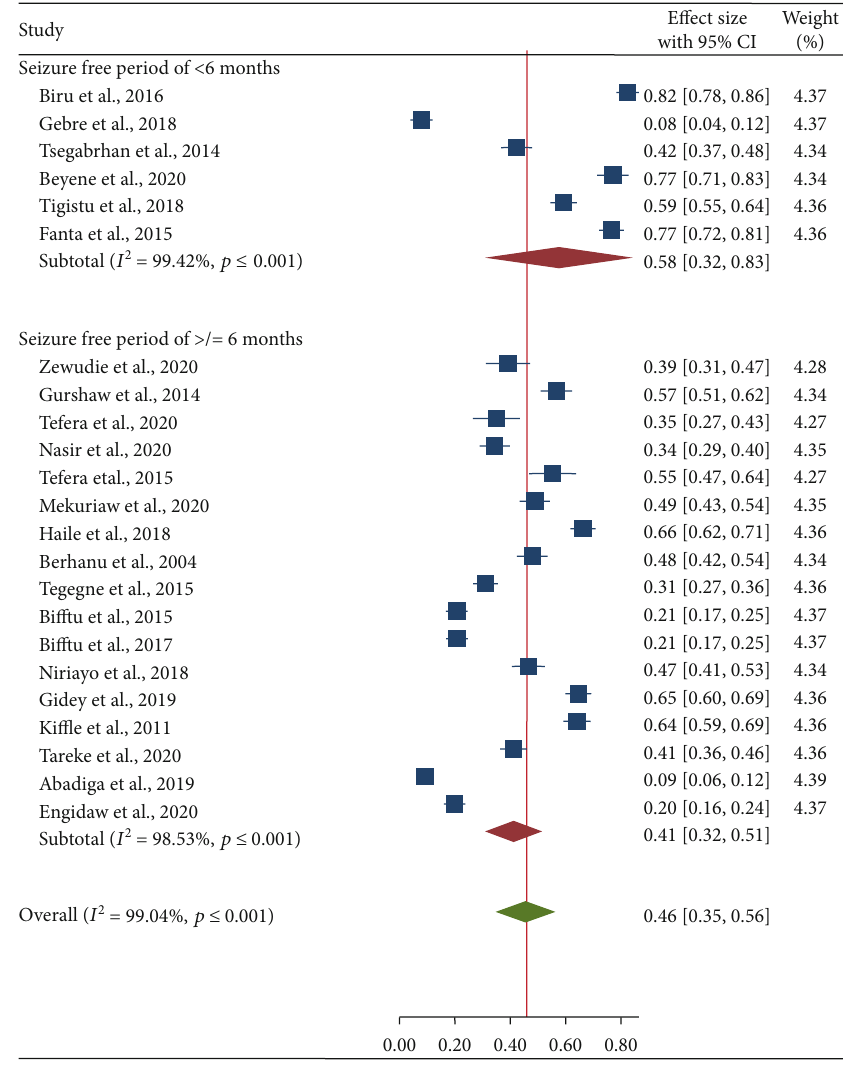
Figure 5: Forest plot illustrating subgroup analysis of seizure freedom by seizure-free period.